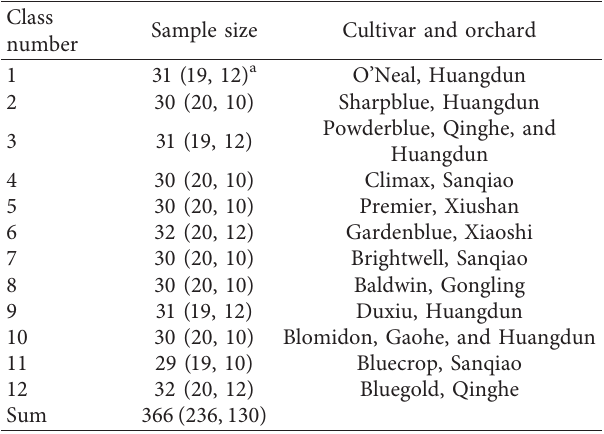
Table 1: Blueberry samples of 12 different cultivars collected in Huaining (Anhui